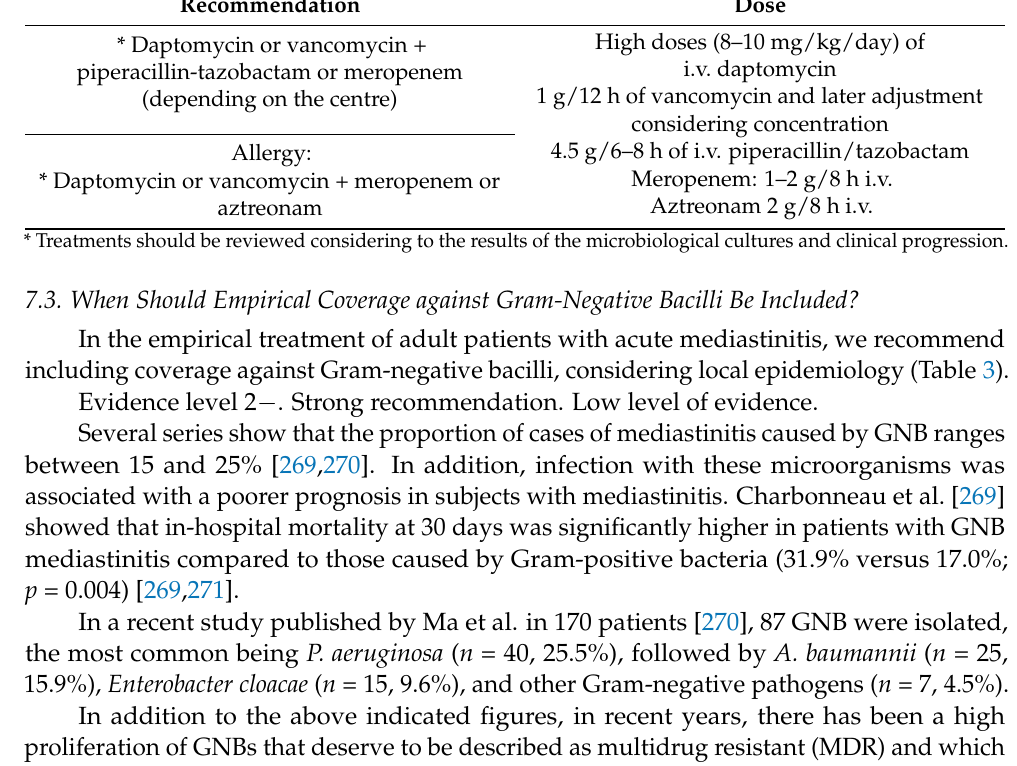
Table 3. Recommendations for empirical antibiotic treatment. Recommendation